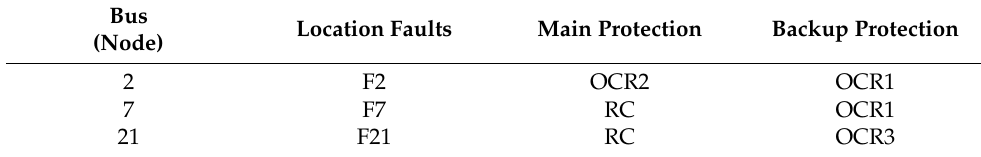
Table 2. Coordination criteria according fault